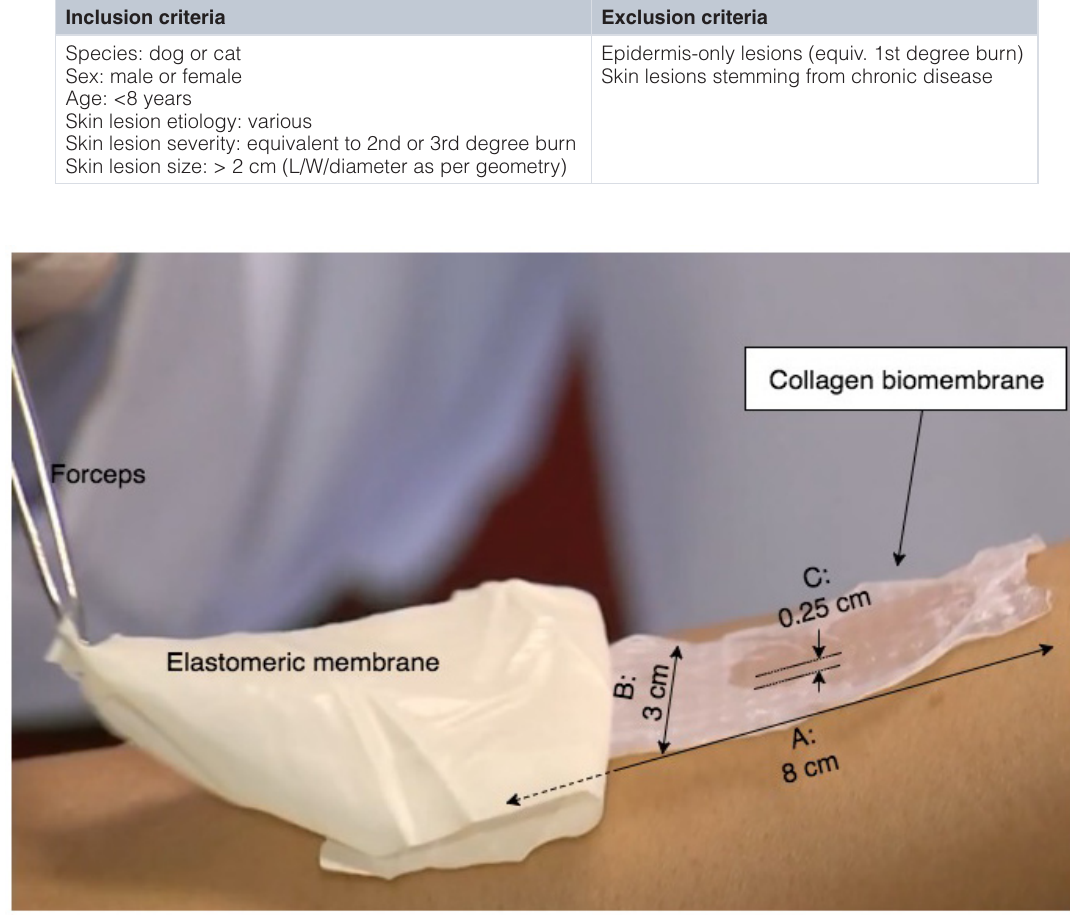
Figure 2. Regenerative collagen biomembrane (Eva Scientific Ltd, São Paulo, Brazil). The biomembrane measures 8×3 cm, and is scattered with small ridges throughout the structure, measuring approximately 100 μm in height, and a spacing of 0.25 cm between each elevated ridge. The standard presentation of the biomembrane is with a synthetic elastomeric membrane underlying the biomembrane itself; when applied to the treatment area, the device (double-layer synthetic membrane / biomembrane structure) is placed biomembrane-side down onto the treatment area, and the synthetic membrane carefully peeled away with a forceps, leaving behind the biomembrane (see Supplementary File 3 for footage of this application